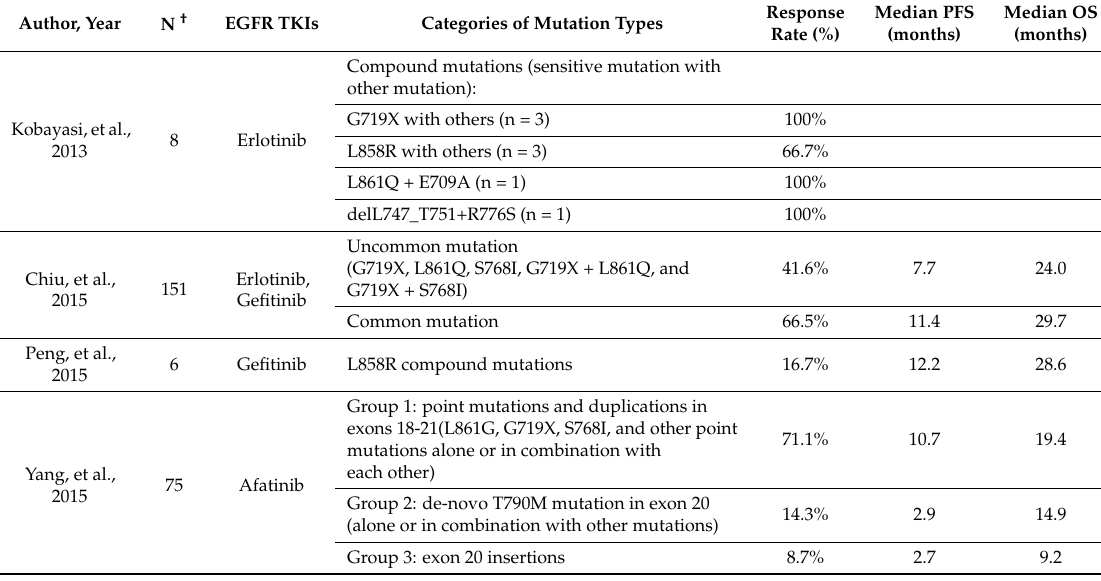
Table A1. Studies about lung cancer harboring rare EGFR